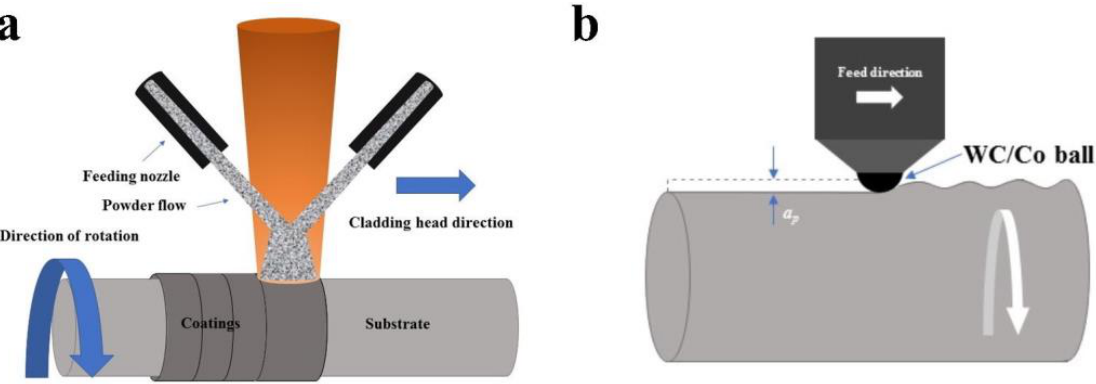
Figure 2. ( a ) Schematic of LC-HEACs and ( b ) ultrasonic surface mechanical rolling treatment. Reprinted with permission from [19] 2020 Elsevier.